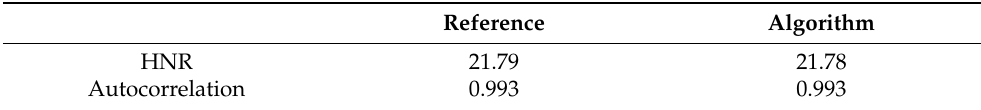
Table 5. Autocorrelation and HNR values on a generated